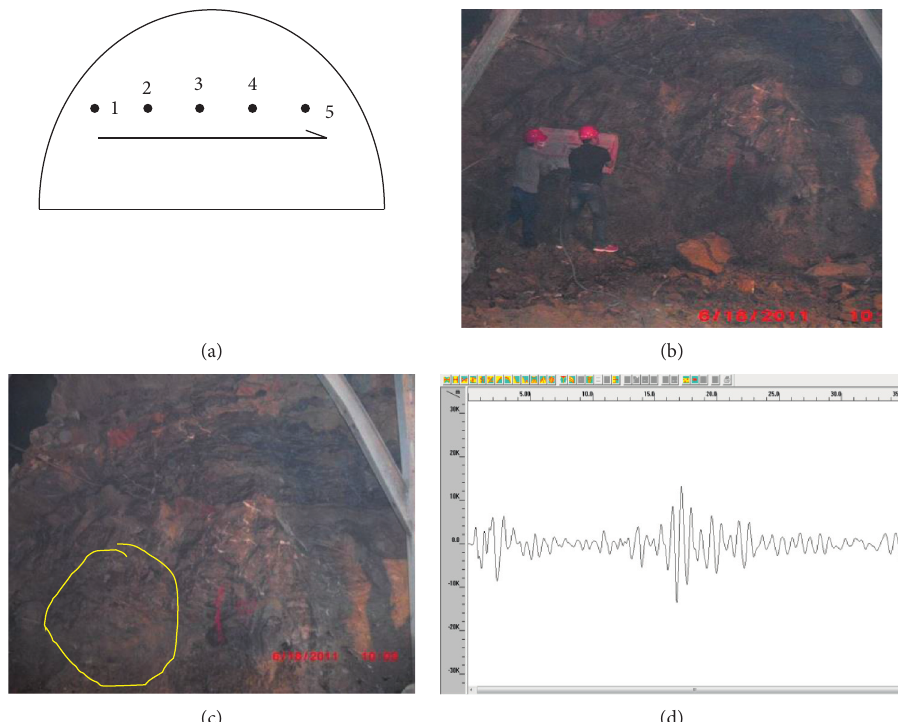
Figure 9: Antenna and markings. (a) Layout of testing points. (b) Radar antenna. (c) Radar marking on the wall. (d) Original radar